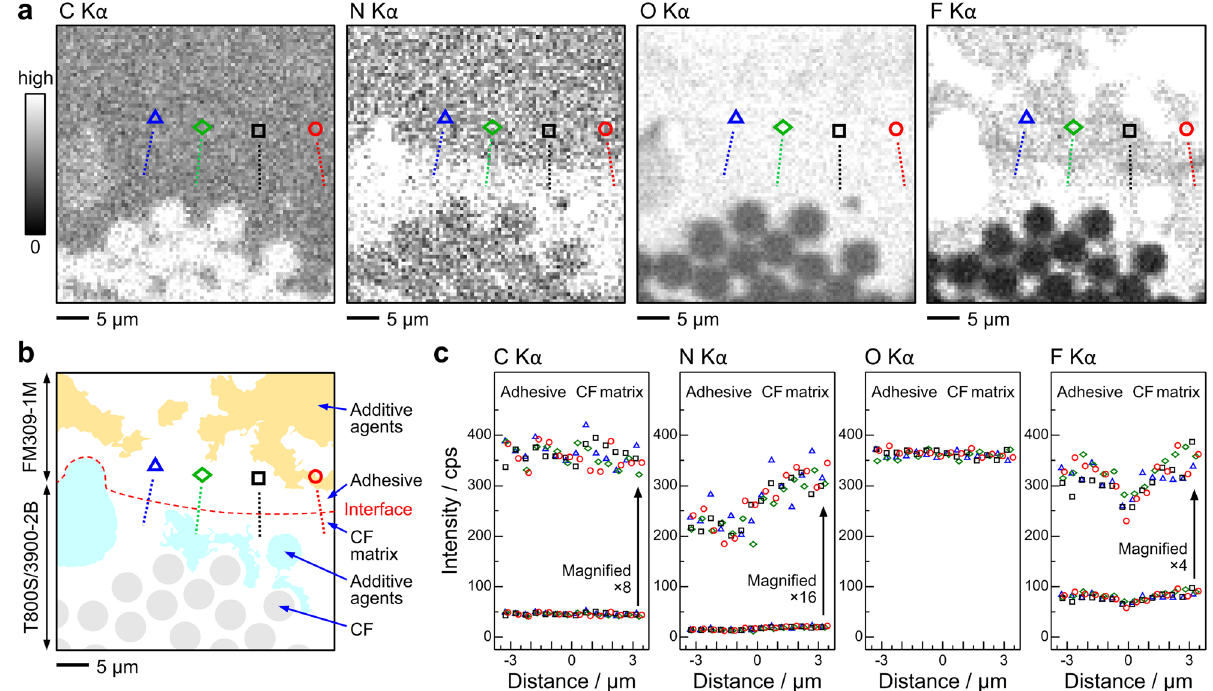
Figure 4. Intensity profile analysis of the soft X-ray images at the CF-matrix/adhesive interface. ( a ) The C, N, O, and F Kα SXM images at the CF-matrix/adhesive interface region. The intensity profile analysis around the interface was performed along the four straight lines with the circle, square, diamond, and triangle symbols. These symbols refer to those used in the intensity plot. ( b ) The segmented image of the CF-matrix/adhesive interface. The intensity profile analysis across the interface was performed along straight lines indicated with the circle, square, diamond, and triangle symbols. ( c ) The intensity profile for the C, N, O, and F Kα emissions at the CF-matrix/adhesive interface. The abscissa is the distance measured from the interface. The circle, square, diamond, and triangle data points correspond to the symbols in the segmented